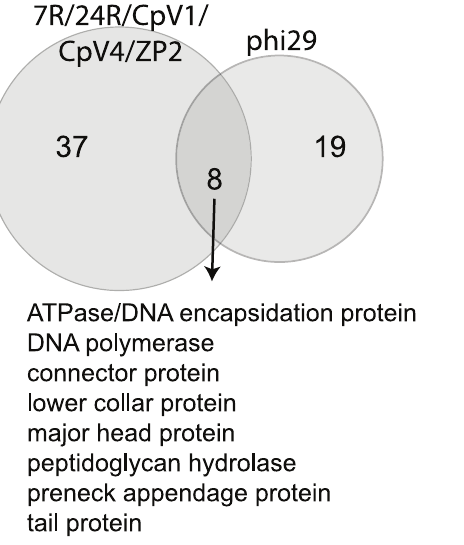
Figure 8. Shared and Unique Genes present in Bacillus phage W 29 versus Bacteriophages W CPV4, W ZP2 and W CP7R. Gene clustering was determined by uclust and blastp as described in the methods